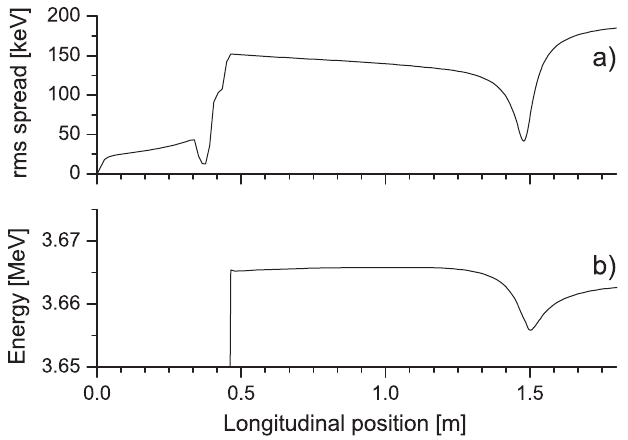
FIG. 4. GPT simulation result for (a) energy spread and (b) average kinetic energy as a function of longitudinal position.